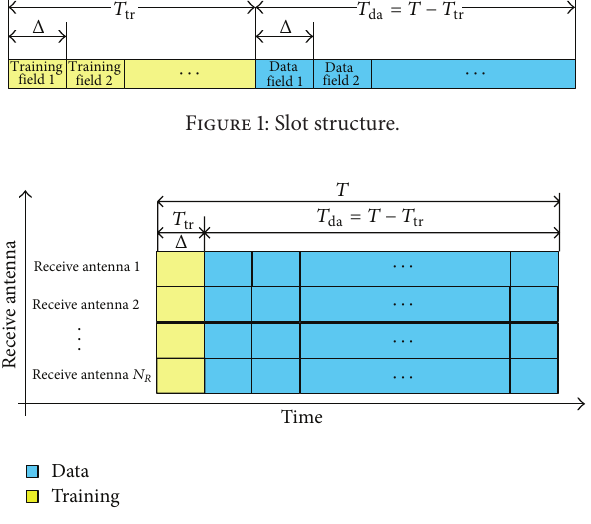
Figure 2: A channel estimation example for full-MIMO systems.